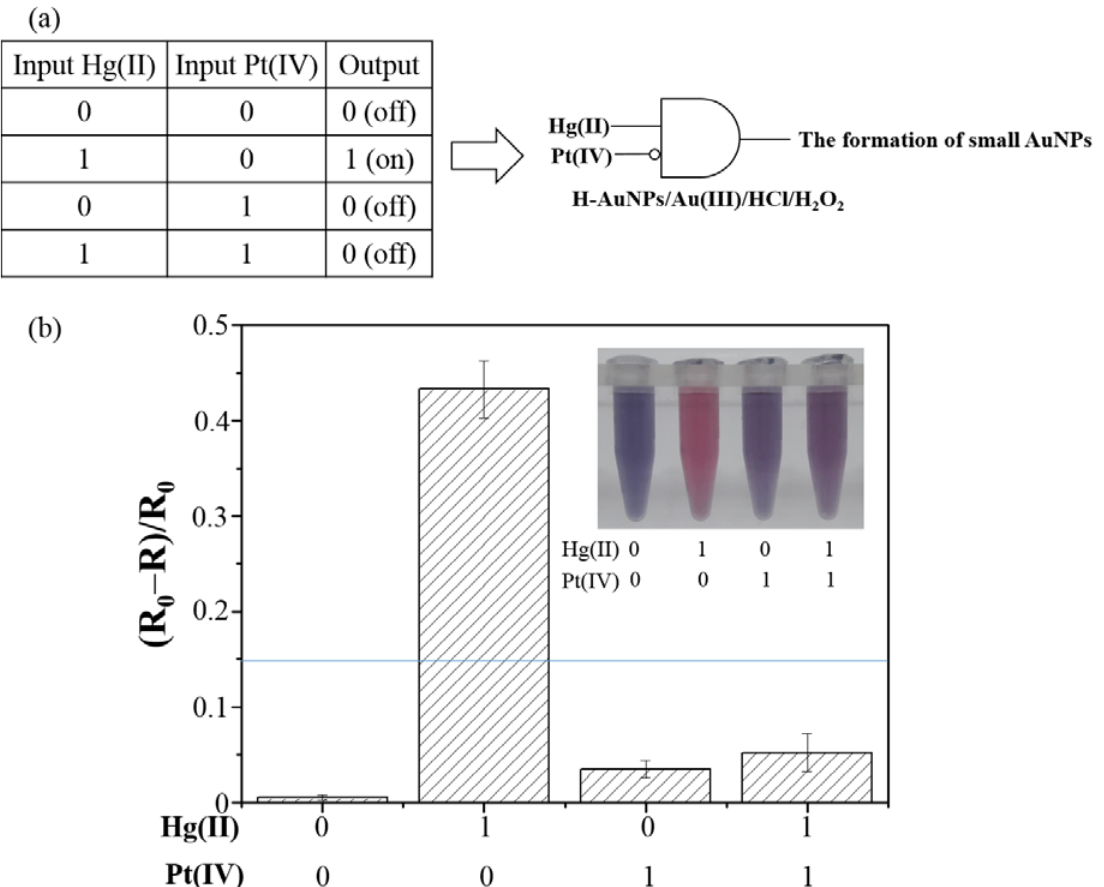
Figure 10. NIMPLY logic gate constructed using Hg(II)/Pt(IV) ions and the H-AuNS probe in the presence of HCl/Au(III)/H 2 O 2 solution. ( a ) Schematic representation of the NIMPLY logic gate “Hg(II)/Pt(IV)(NIMPLY)–HAuNP”; ( b ) Bar diagram of output signals (formation of small AuNPs) in response to four different combinations of two inputs, Hg(II) (0, 10 µM) and Pt(IV) (0, 10 µM). The threshold line is set to the 0.3-fold signal output of true (on). Error bars represent standard deviations from three repeated experiments. Other conditions were the same as those described in Figure 1.